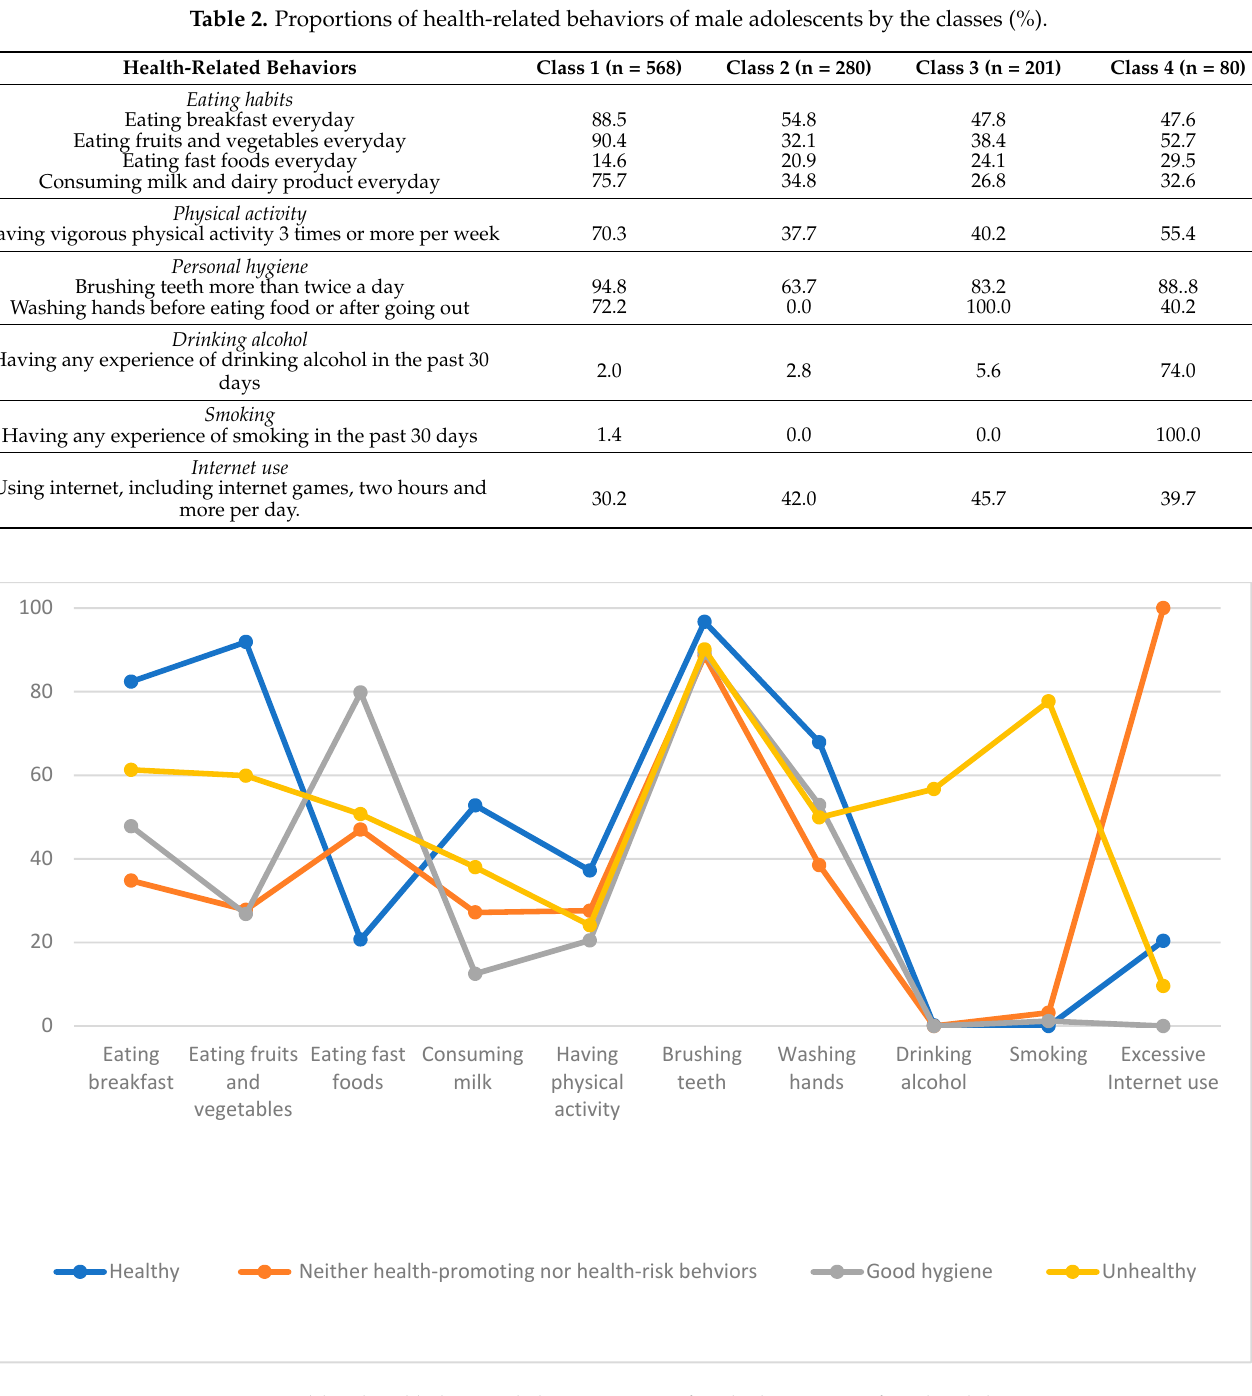
Figure 2. Health-related behavioral characteristics of each class among female adolescents .